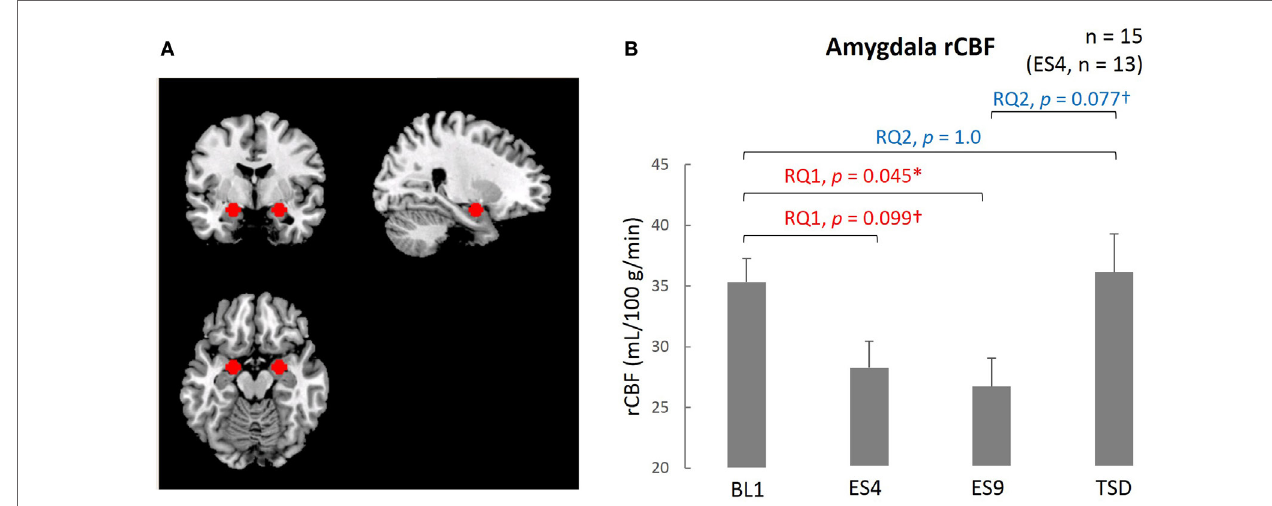
FigUre 3 | Comparison of the amygdala ROI and rCBF among different sleep conditions. (a) Amygdala ROI. Left amygdala: center MNI coordinates ( x , y , z ) = ( − 20, − 4, − 16) mm, 179 contiguous voxels; right amygdala, ( x , y , z ) = (24, − 4, − 16) mm, 178 contiguous voxels; clusters are rendered on a T1 anatomical reference image displayed in neurological convention, with the left side corresponding to the left hemisphere. MNI, Montreal Neurological Institute template. (B) Amygdala rCBF for the four sleep conditions. * p < 0.05, † p < 0.1; p values were adjusted for multiple comparison. Data were analyzed based on the following two research questions: (RQ1) Comparison between BL1 and ES9 to investigate the effect of extended sleep ( t test for KSS and STAI-S and Wilcoxon signed-rank test for PANAS-NA); (RQ2) Comparison between BL1 and TSD to determine whether the TSD would erase the effect of sleep extension and whether the subjective indices after TSD would be comparable to those at the baseline level. RQ, research question; rCBF, regional cerebral blood flow; BL1, baseline Day 1; ES4, extended sleep Day 4; ES9, extended sleep Day 9; TSD, total sleep